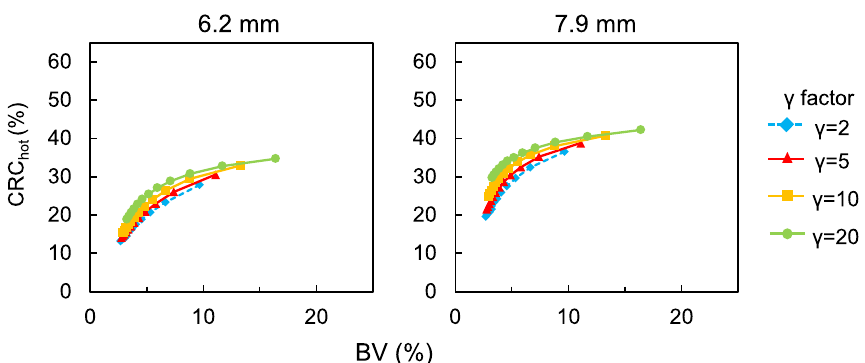
Fig. 7 Relationships between CRC hot and BV curves of hot spheres with inner diameters of 6.2 and 7.9 mm determined using BPL reconstruction with various γ factors. Values for BPL curve run from left to right as β values decrease